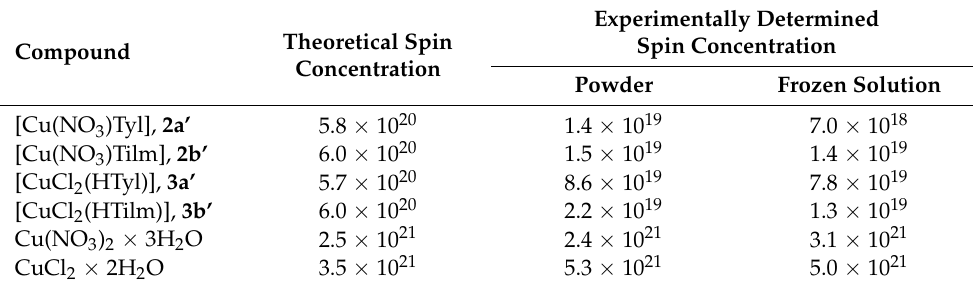
Table 4. Spin concentration (spin numbers per gram sample) in the blue and green coordination compounds (treated as pure mononuclear complexes) and copper(II) salts. Experimentally Determined Theoretical Spin Spin Concentration Compound Concentration